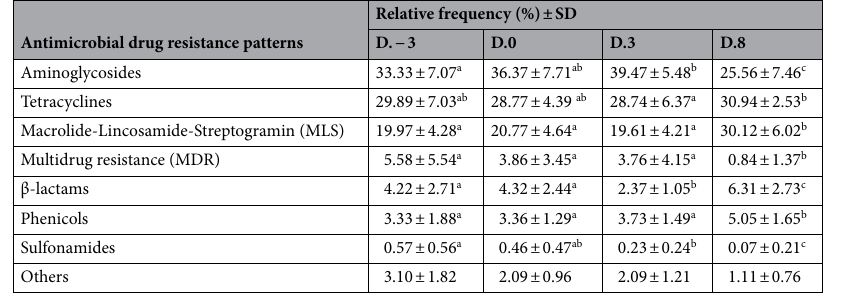
Table 4. Percent of fragments per kilobase of exon model per million reads mapped (FPKM) of antimicrobial drug resistance patterns in piglets at day 3 pre-weaning (D. − 3), weaning day (D.0), days 3 (D.3) and 8 post- weaning (D.8). a,b,c A significant difference in the same row at P < 0.05.